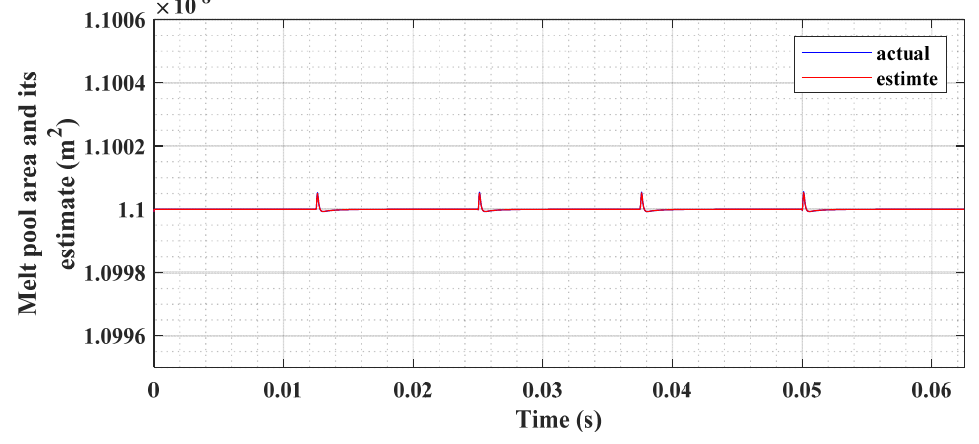
Figure 10. Actual melt pool area and its estimate from the ESO.